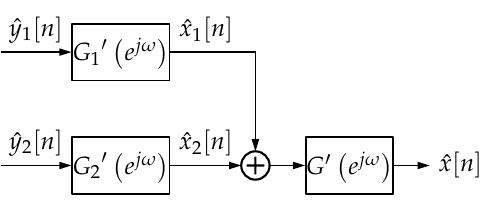
Figure 3. Realization of G 1 and G 2 in classical DBI system for two